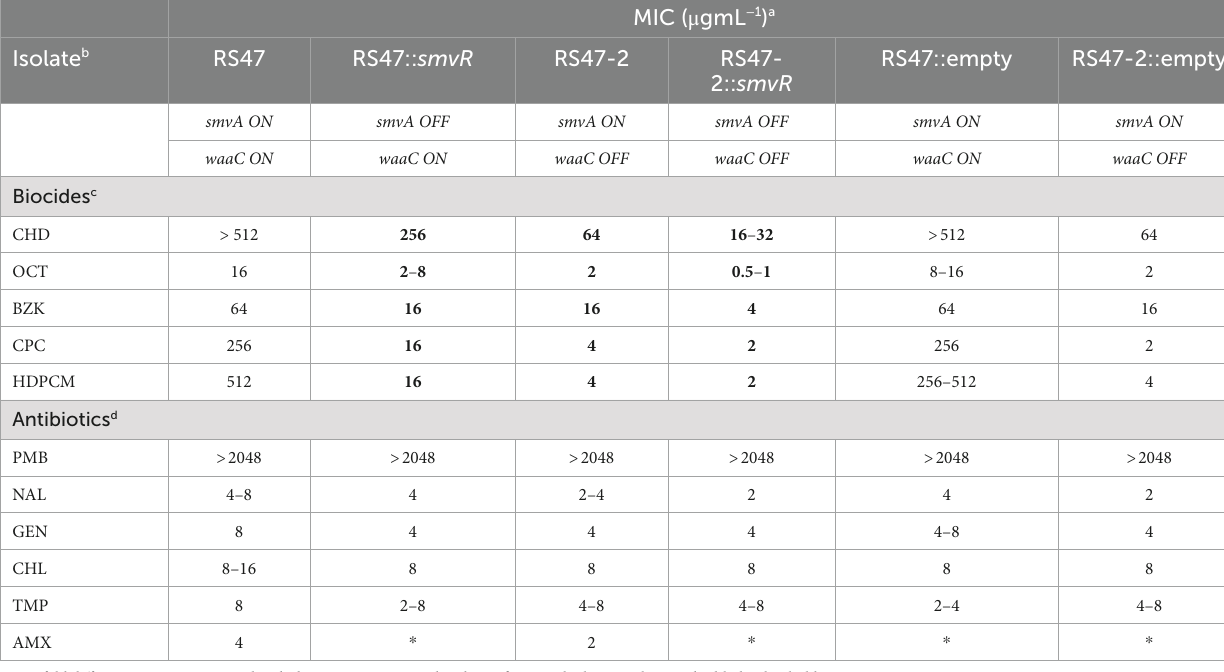
TABLE 3 Minimum inhibitory concentrations (MICs) values of various biocides and antibiotics for wild-type, mini-tn5 mutants and complemented isolates ( n =